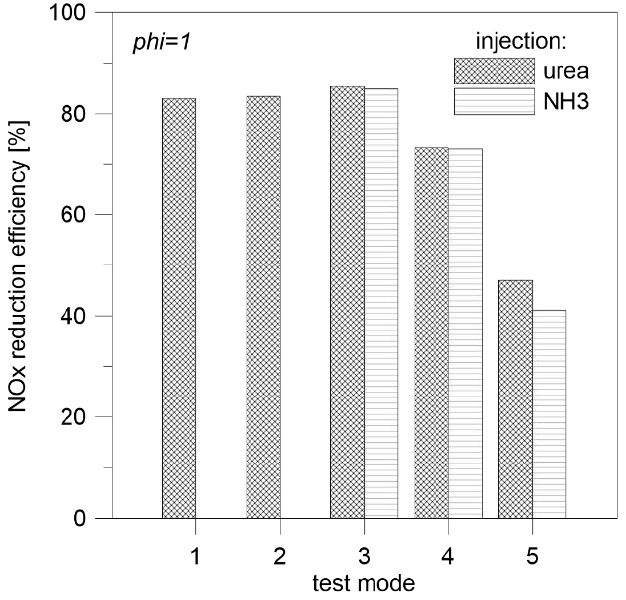
Figure 10. NO x reduction efficiency at phi = 1 for urea and gaseous NH 3 injection.